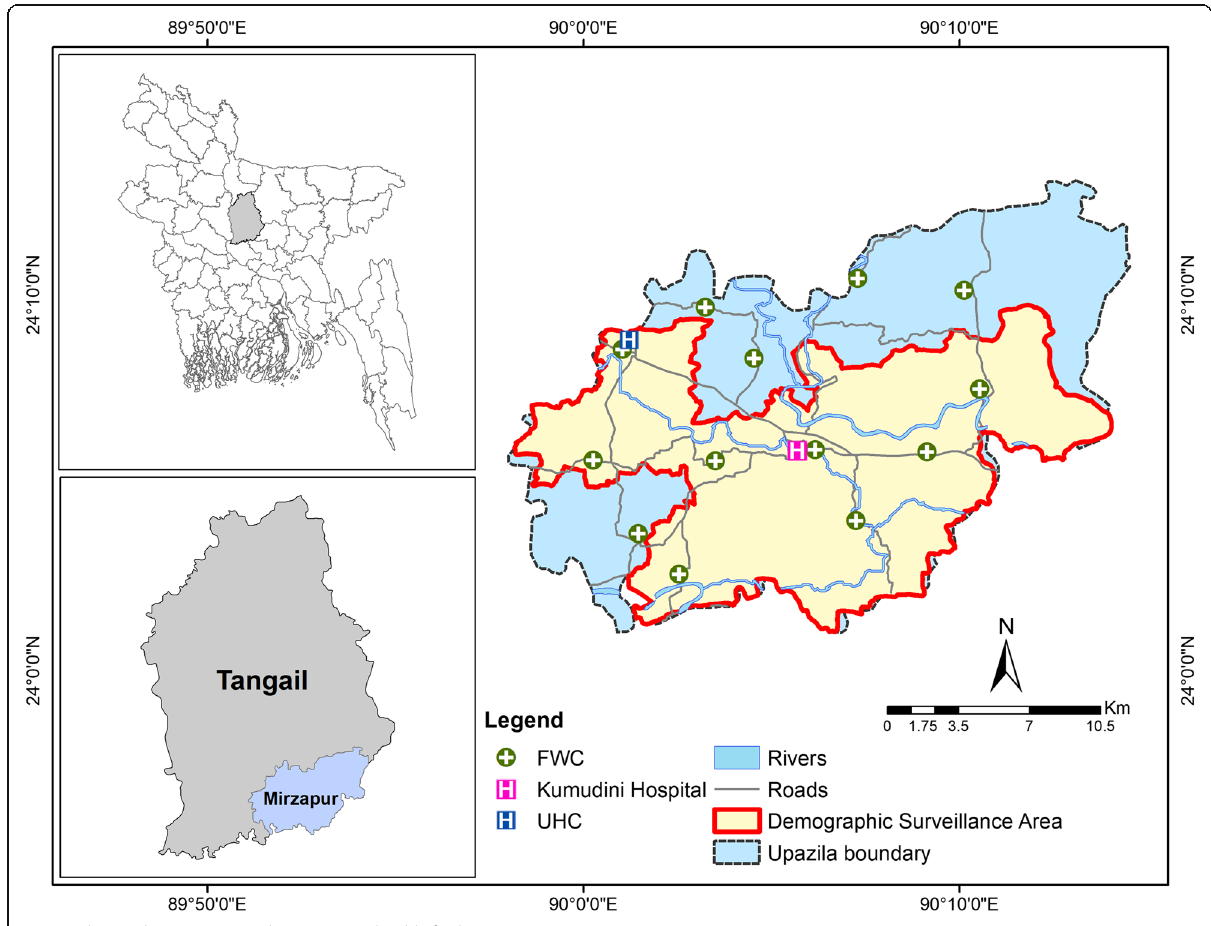
Fig. 1 The study area map with prominent health